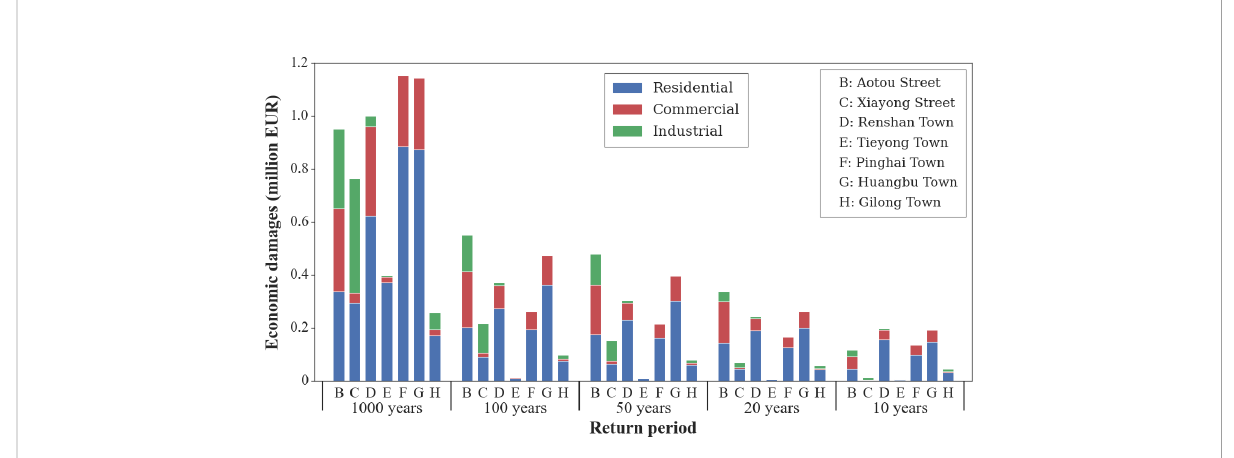
FIGURE 12 The estimated economic damage for different categories of buildings in 8 streets/towns under fi ve different typhoon